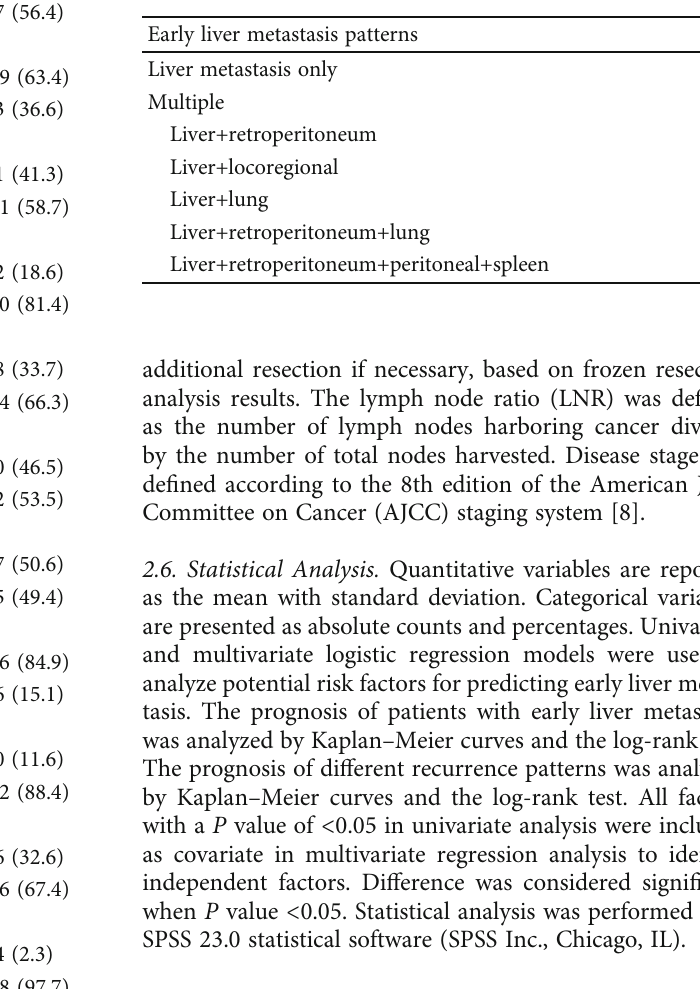
Table 2: Recurrence patterns of patients with early liver metastasis ( n = 55